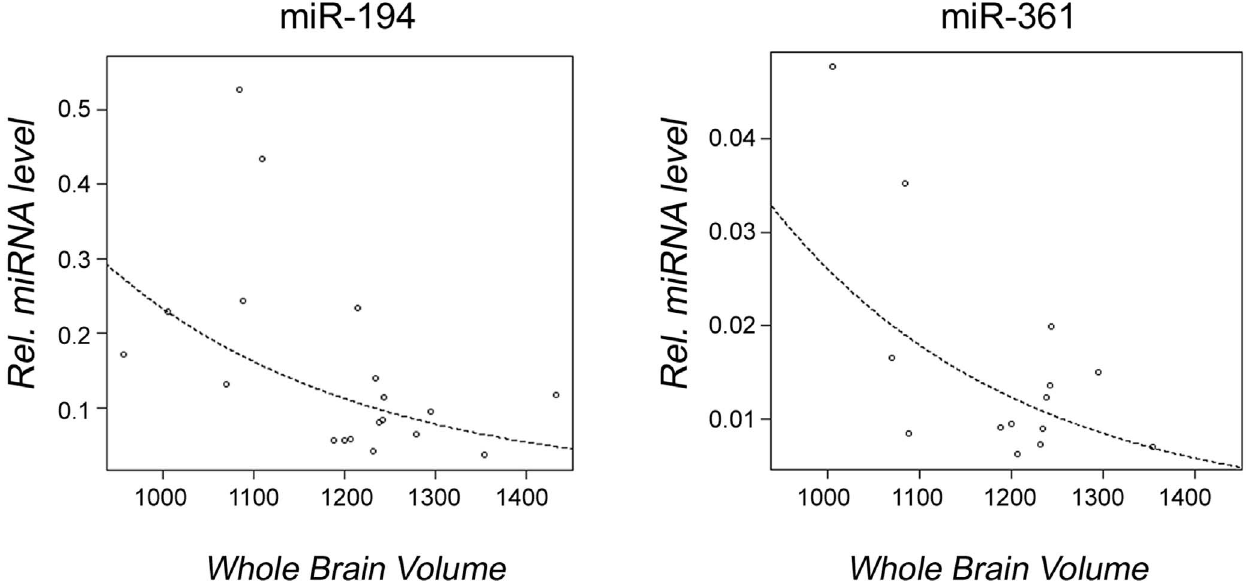
Figure 7. Observed correlation between dysregulated miRNAs and whole brain volume. Graphs showing a significant correlation between miRNA expression levels and whole brain volume within the individuals with 22q11DS are shown. Open circles represent individuals with 22q11DS; the line represents line of best fit. P-values given are for each miRNA.